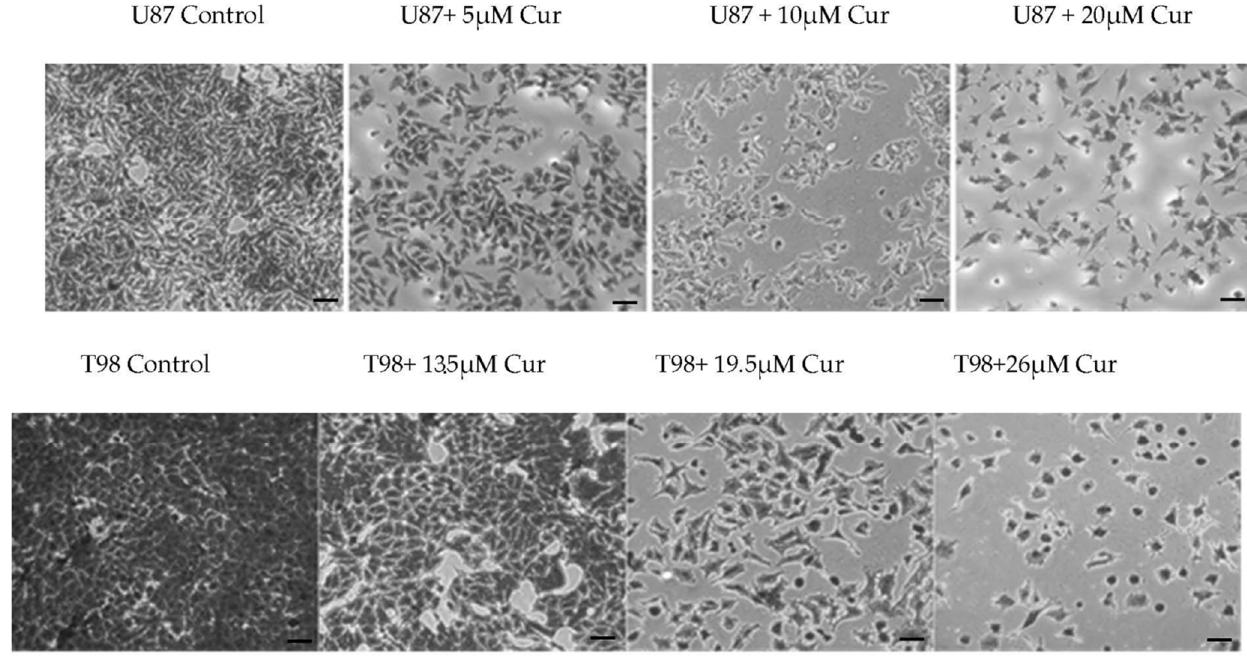
Figure 3. Morphological changes in U87 ( a ) and T98 ( b ) cell populations after treatment with crystal violet staining (0.2% Crystal Violet) (Scale bars = 50 μm). Images were recorded at 10× magnification. Cells were seeded in 6-well plates and 24 h later exposed to increasing curcumin concentrations. Crystal violet solution was added 48 h later and the cells were incubated at room temperature for 2–3 min. The excess crystal violet was removed, and plates were washed twice and left overnight to dry.